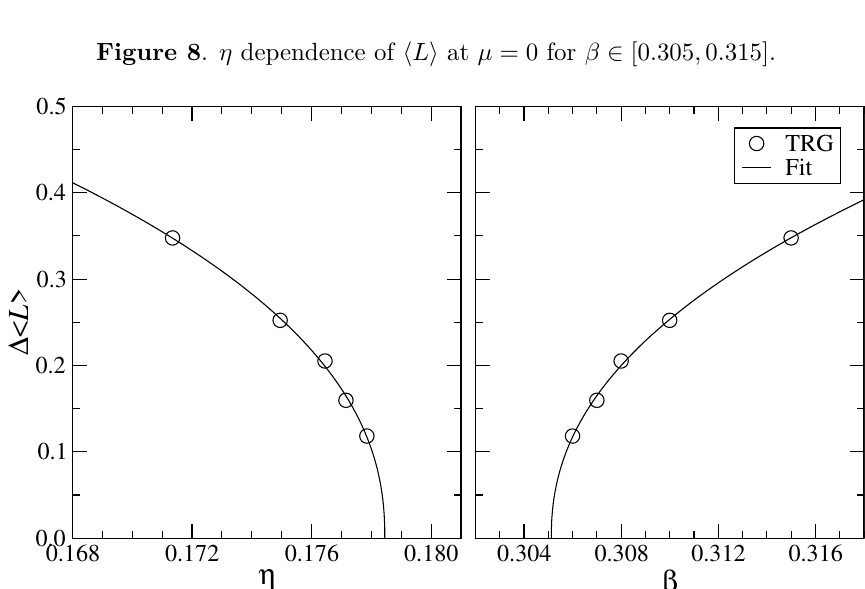
Figure 9 . (Left) Fit of ∆ h L i at µ = 0 as a function of η . (Right) Fit of ∆ h L i at µ = 0 as a function of β